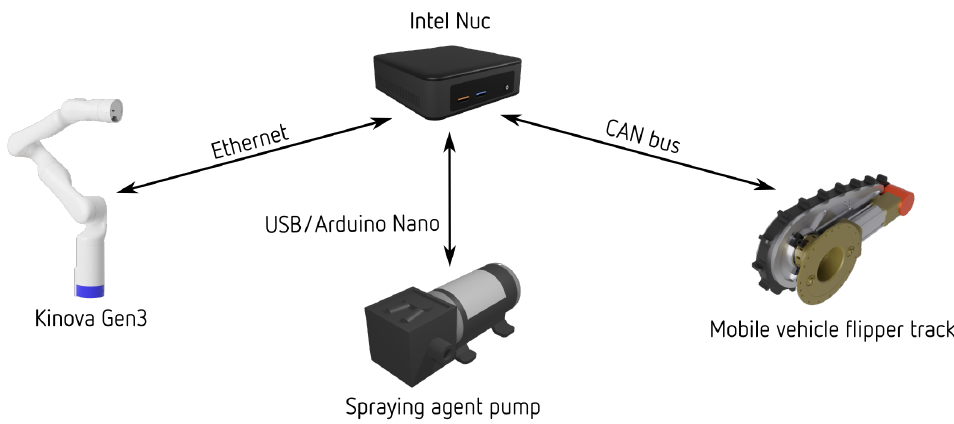
Figure 7. Communication diagram of the equipment used in the vineyard spraying